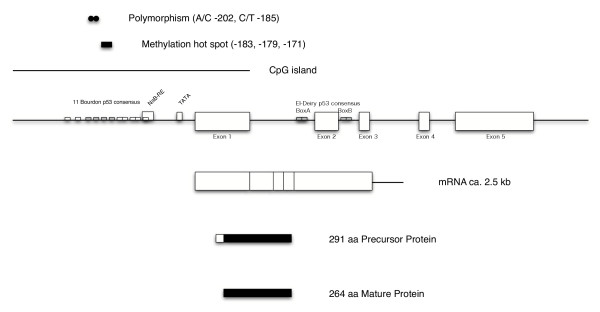
Schematic genomic structure of the IGFBP3 gene. There exist 11 p53 consensus sequences upstream of the promoter [16] and two binding sites in introns [3]. Polymorphisms and hypermethylations are identified in the promoter upstream p53 binding sites [26, 12].